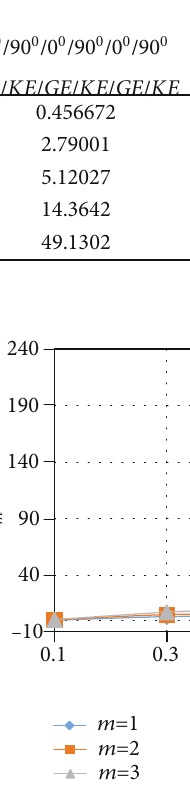
Figure 3: Variation of angular frequency and radius ratio of 6- layered annular circular plates.